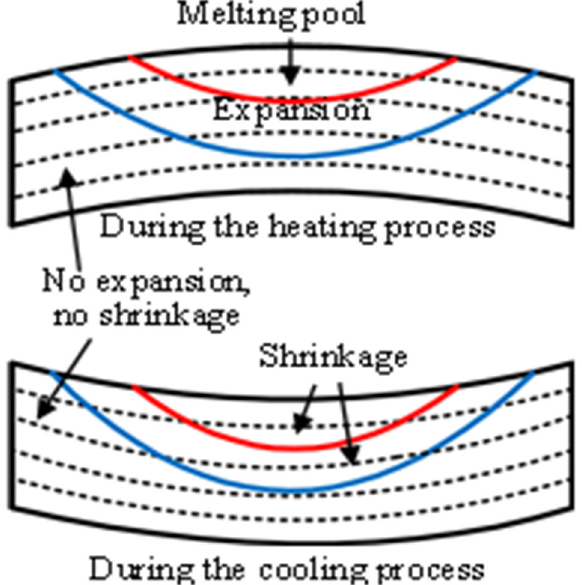
Figure 10. Schematic diagram of distortion during the SLM process. Due to the rapid heating of the heat source on the latest layer, a melting pool develops and the material below the melting pool is heated and expands. The region near the melting pool, which has a higher temperature, has more expansion. The expansion exerts a downward component force and an outward component force on the surrounding material. When the material yield stress, which is lowered due to the elevated temperature, is reached, a counter bending away from the melting pool will be perceived. During the